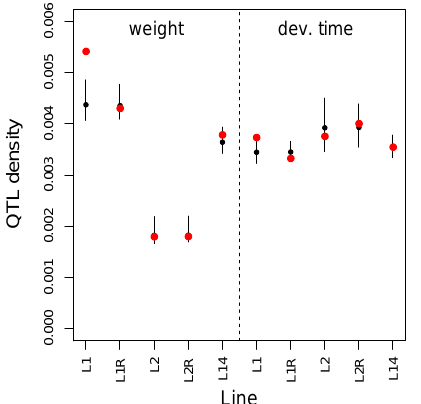
Figure 6. Performance-trait QTL density (number of QTL per SNP) for SNPs exhibiting exceptional allele frequency change in the E&R experiments. Results are shown for adult weight and development time for each pair of lines or samples (see main text for details). Red dots denote the observed density. Black dots (median) and vertical lines (2.5th to 97.5th percentile) denote the null expectations from randomization